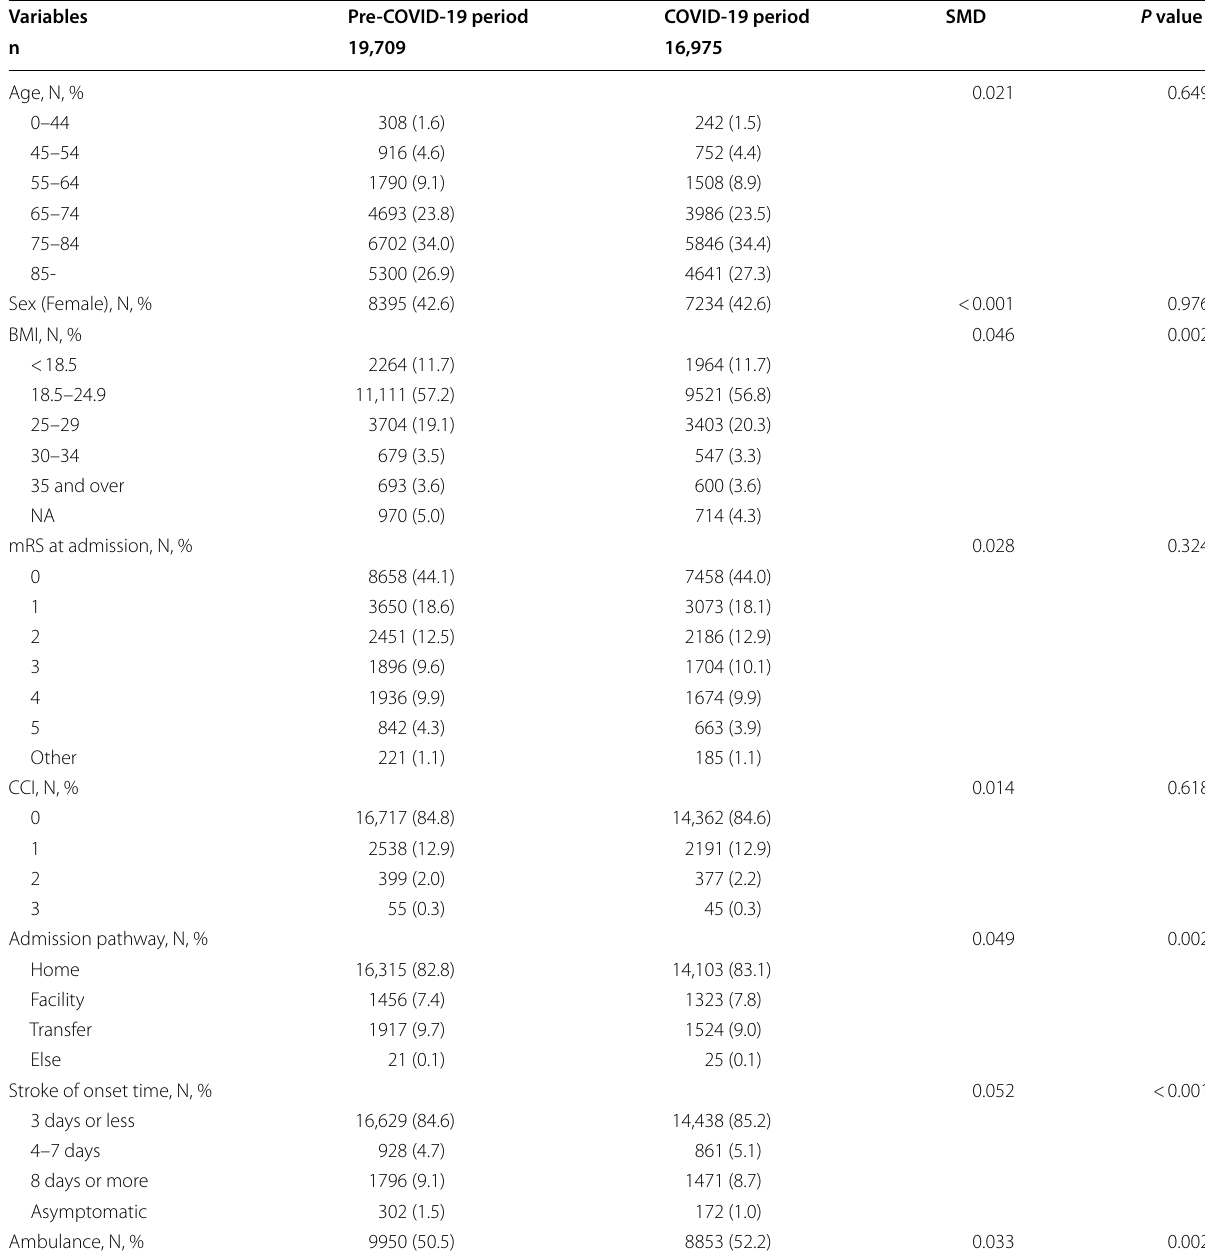
Table 1 Baseline characteristics of patients with